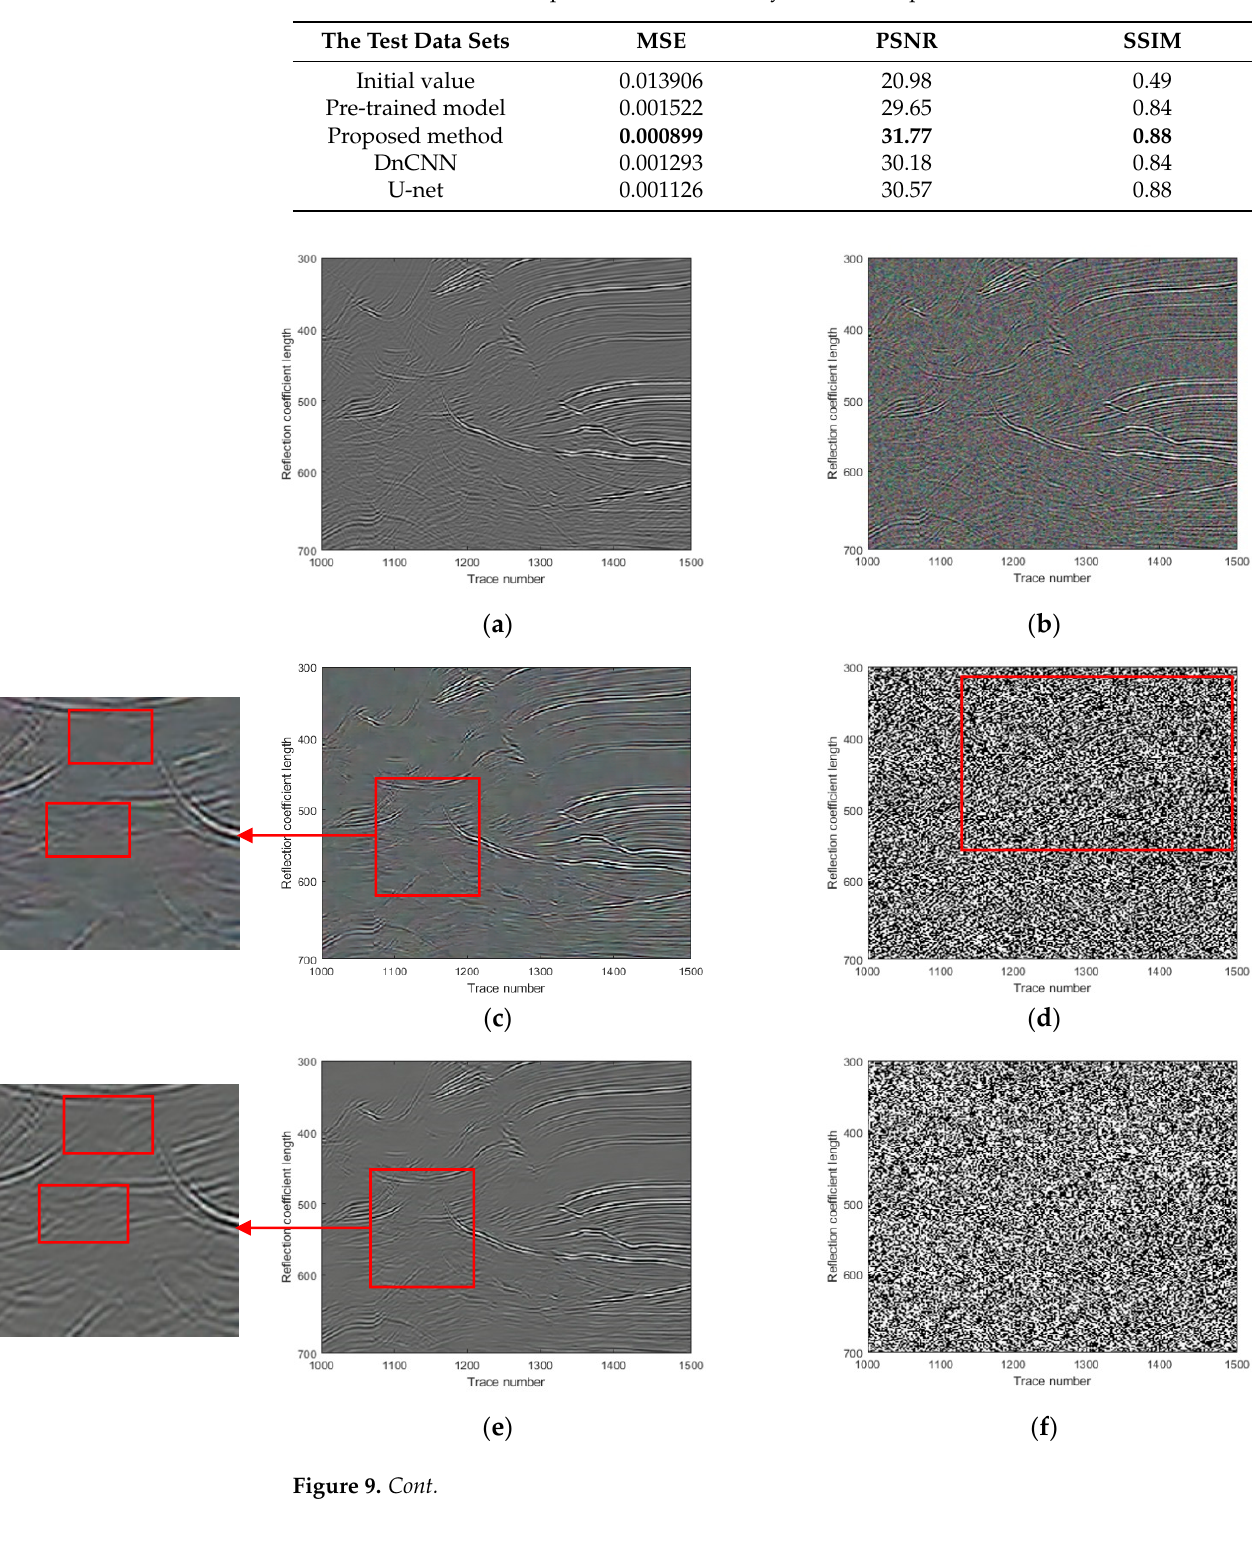
Table 6. Quantitative comparison of the fourth synthetic example.